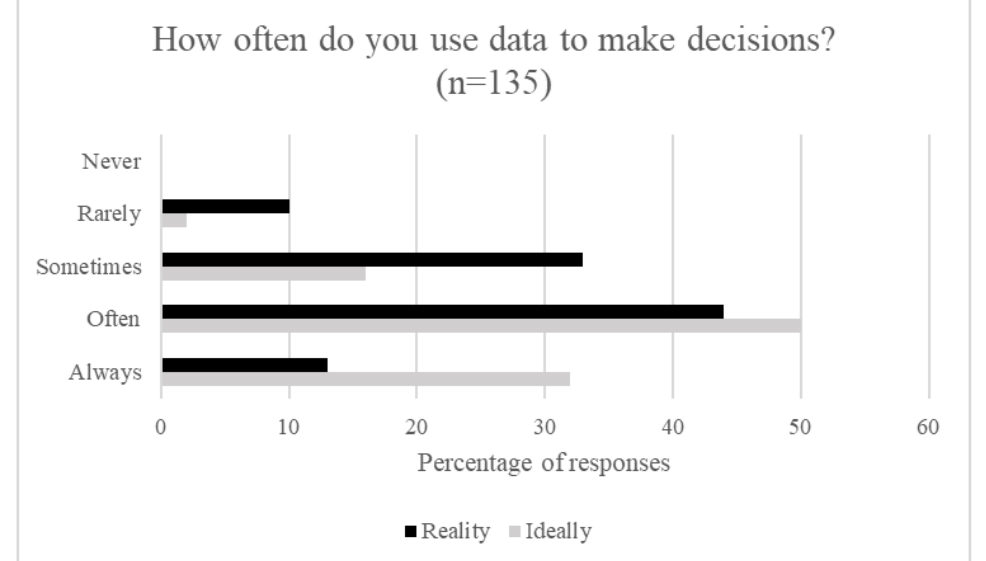
Figure 5. Use of data for decision